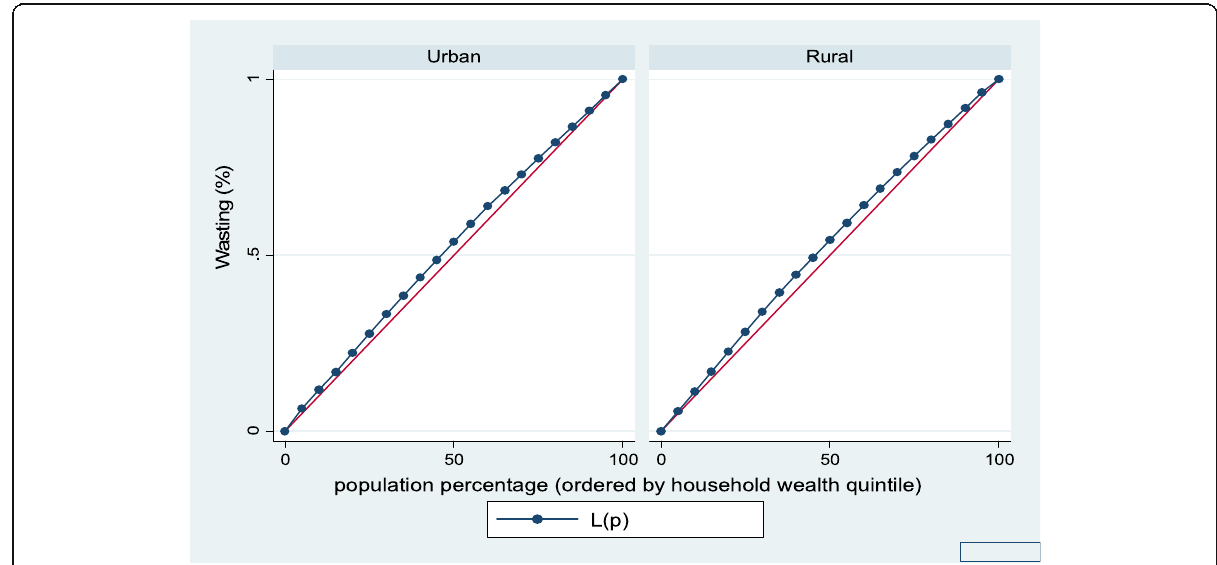
Fig. 2 Urban-rural Lorenz curve for